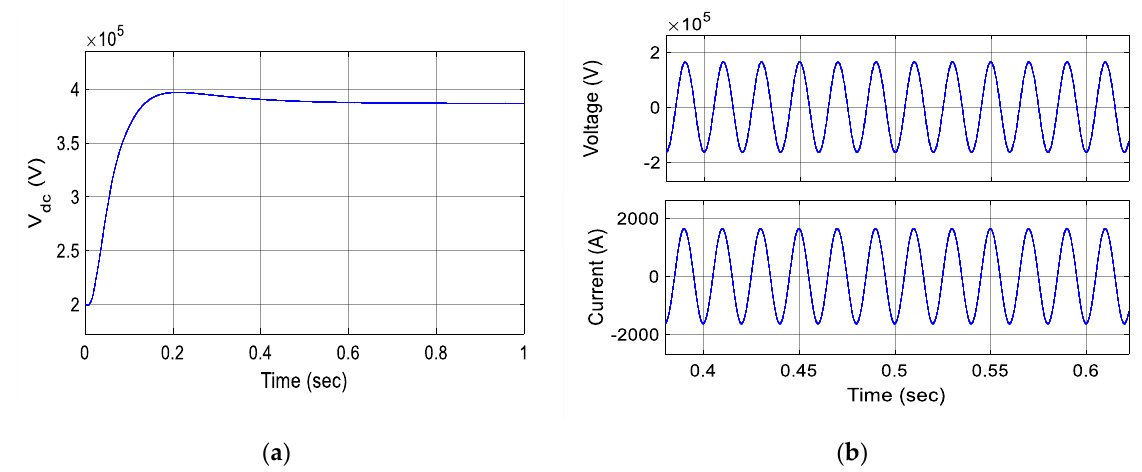
Figure 6. VSC terminal-II voltages and current; ( a ) DC-voltage, ( b ) Voltage and current waveforms.